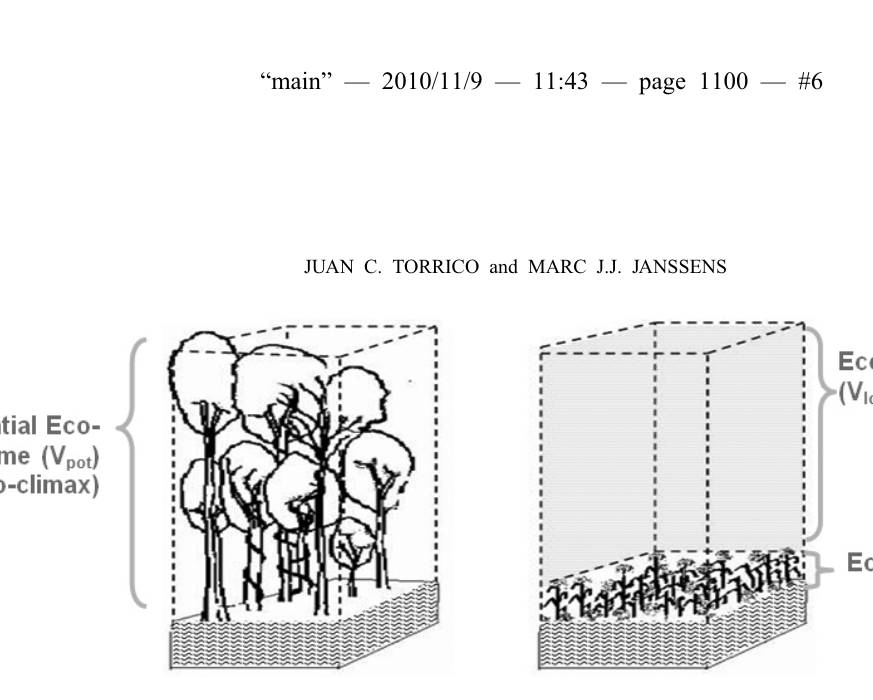
Fig. 1 – Illustration of the potential eco-volume (V pot ), eco-volume (V eco ), bio-volume (V bio ) and eco-volume loss (V loss ).